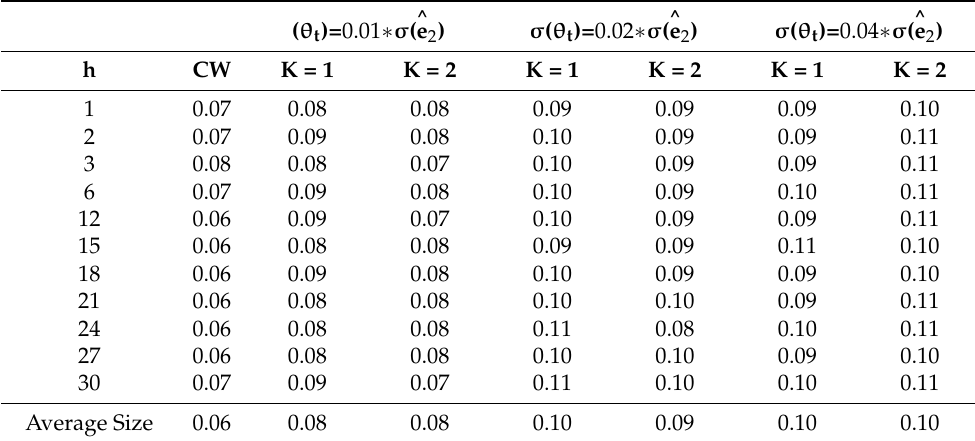
Table 1. Empirical size comparisons between CW and WCW tests with nominal size of 10%, consid- ering DGP1 and a large sample.